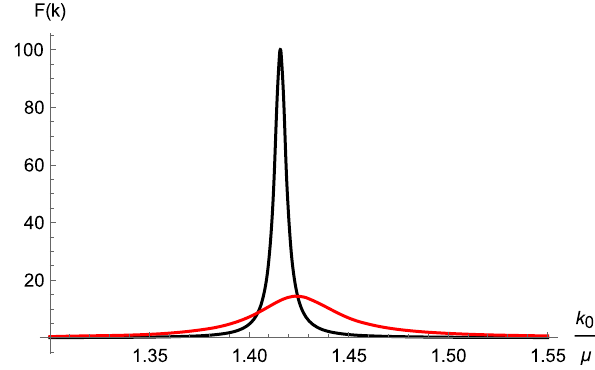
Fig. 4 Variation of the statistical propagator, Eq. (49), with respect to the dimensionless variable k 0 /μ , where we have taken |(cid:5) k | /μ = 1, m /μ = 1 and the Yukawa coupling strengths g = 0 . 5 (black curve), g = 1 . 3 (red